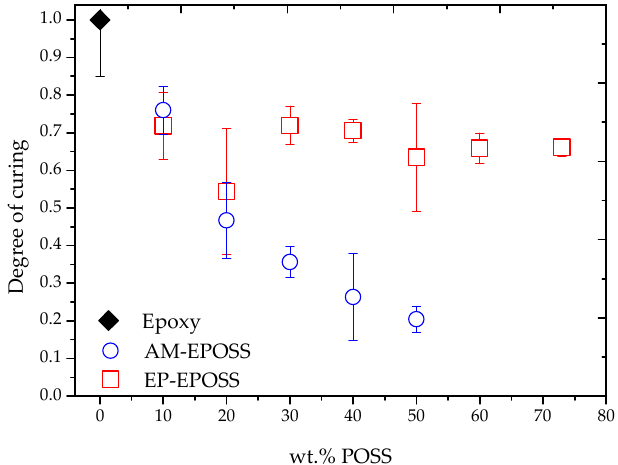
Figure 3. The e ff ect of POSS type and content on the degree of curing of EP–EPOSS and Figure 3. The effect of POSS type and content on the degree of curing of EP–EPOSS and AM–EPOSS.